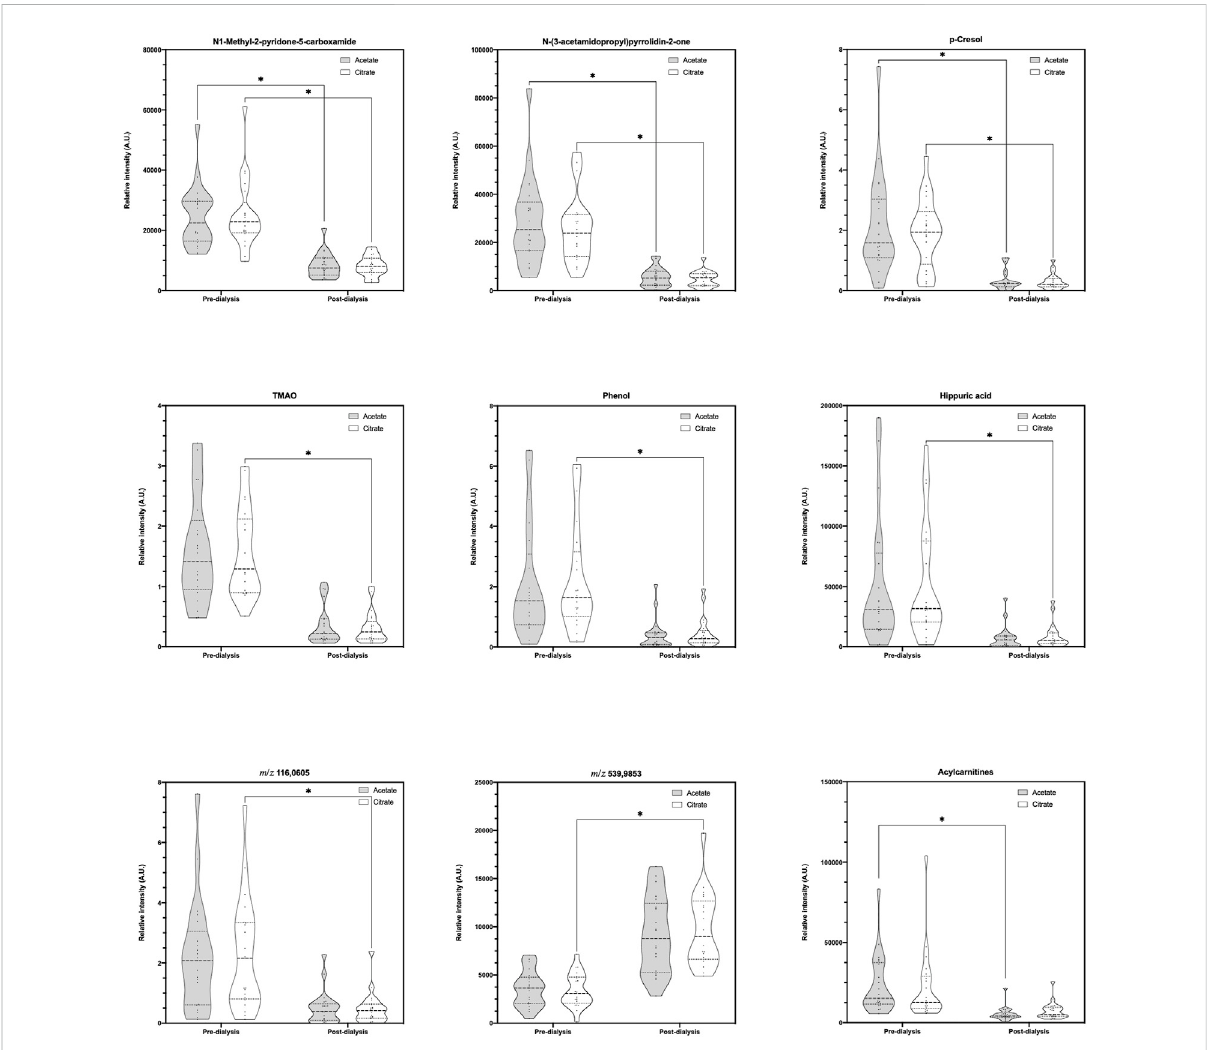
FIGURE 4 Violin plots of selected relative intensities according to clinical interest. *Statistically signi fi cant difference.